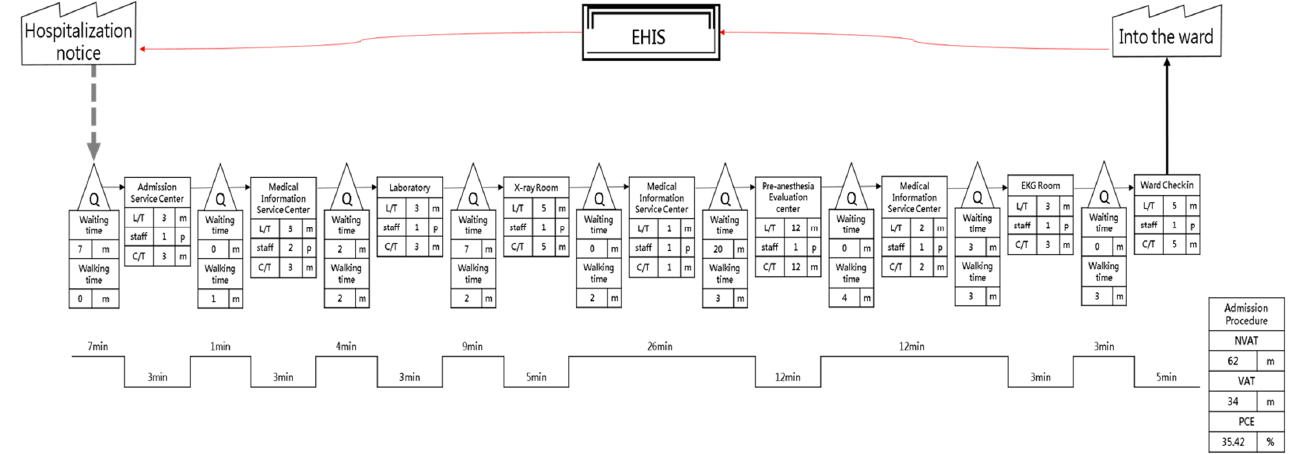
Figure 1. Current value flow chart for the hospital admission procedure. Table 3. Detailed process of the hospitalization procedures.